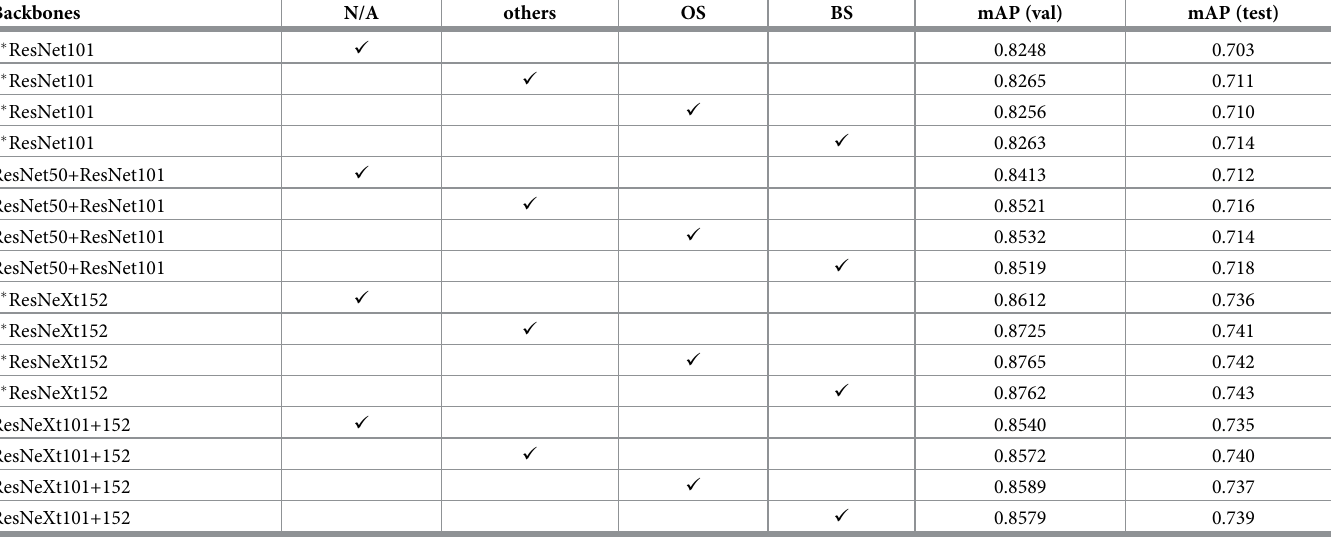
Table 3. Effectiveness of image augmentation operations. N/A refers to taking no image augmentation method. OS and BS are short for object swap and layer swap, oth- ers refer to randomly selected image augmentation methods other than the two newly designed operations.